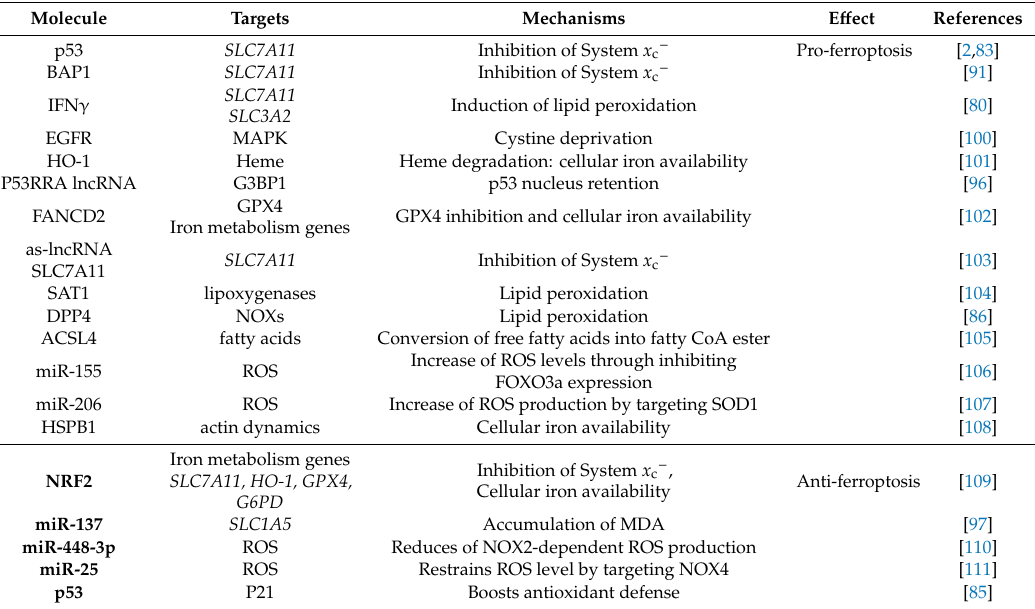
Table 1. Inducers and inhibitors of